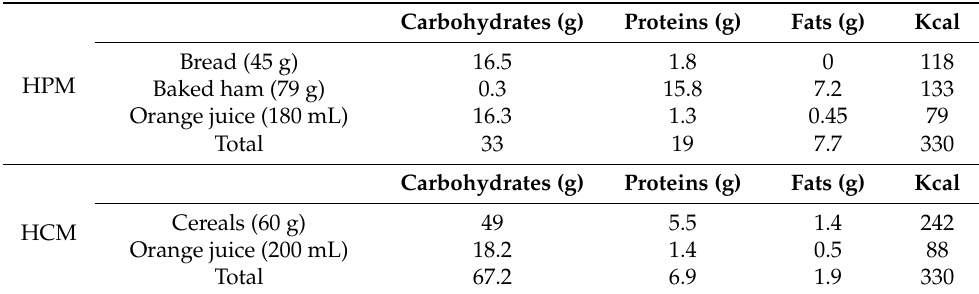
Table 1. Energy and nutrient content of the